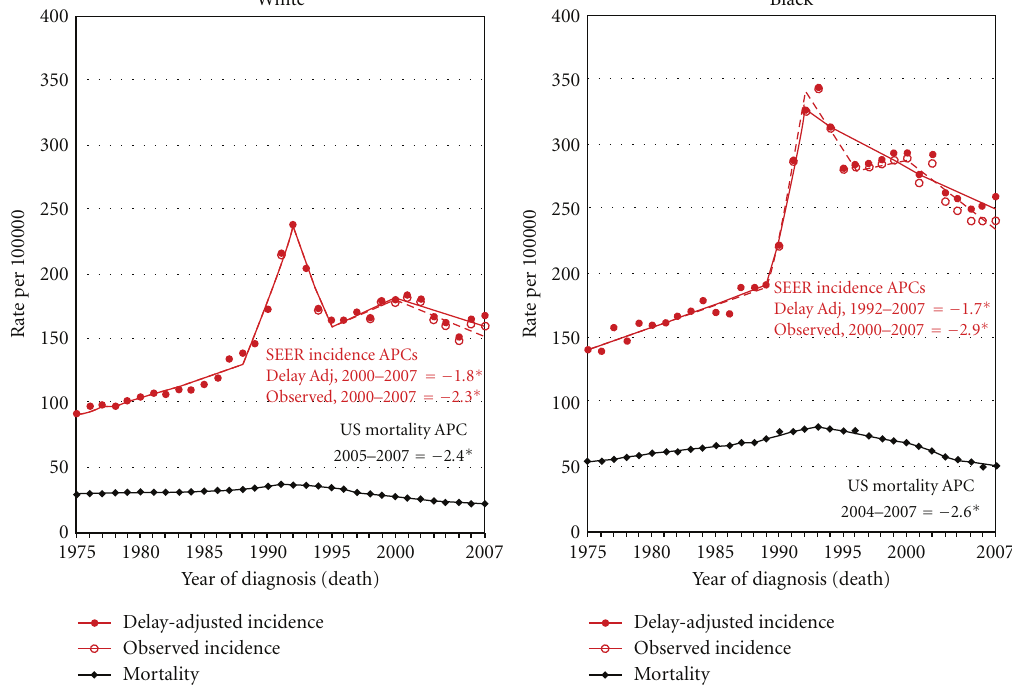
Figure 1: Change in prostate cancer incidence and mortality from 1975 to 2007 documented by the National Cancer Institute. a rates are age adjusted to the 2000 US Std Population (19 age groups—Census P25-1103). Regression lines and APCs are calculated using the Joinpoint Regression Program Version 3.5, April 2011, National Cancer Institute. The APC is the annual percent change for the regression line segments. The APC shown on the graph is for the most recent trend. The APC is significantly di ff erent from zero ( P < 0 .